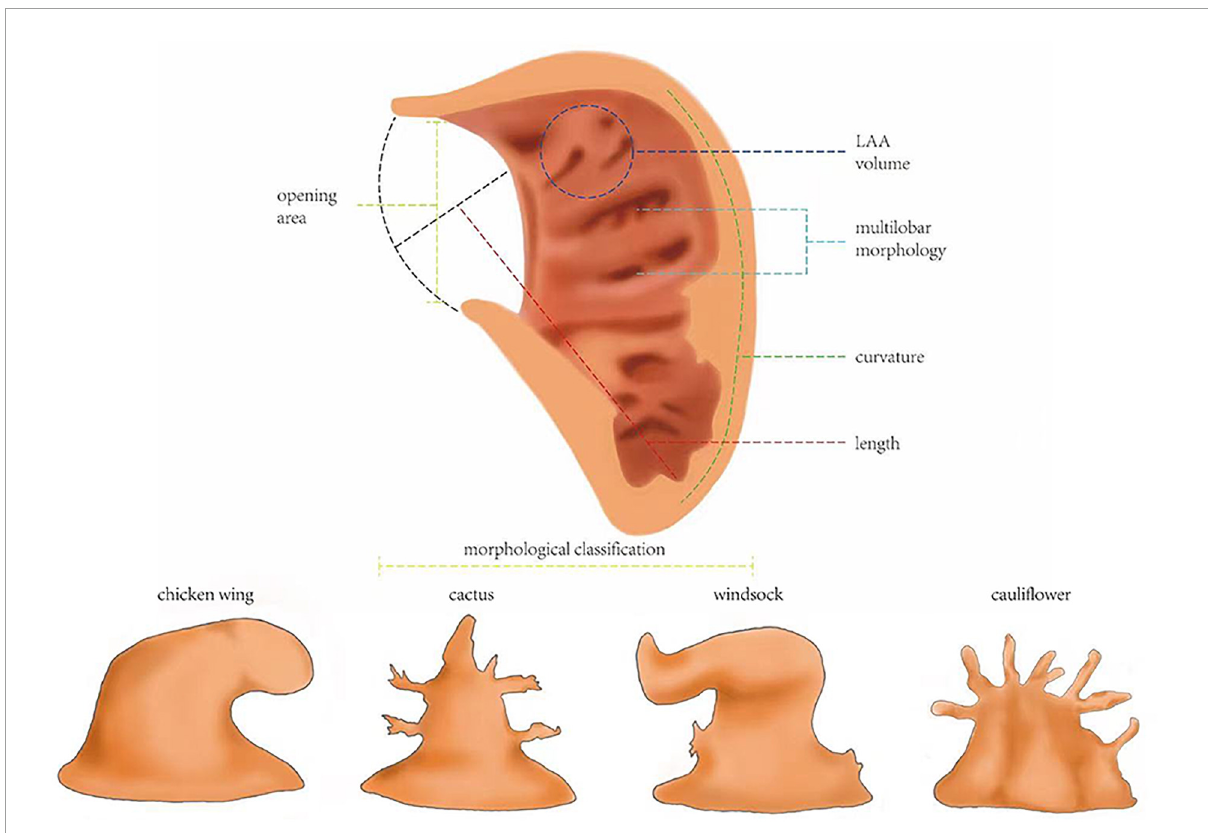
FIGURE2 Definitions of the morphological indicators. Morphological classification: left atrial appendages (LAAs) are divided into four classical types, namely, chicken wing type, cactus type, windsock type, and cauliflower type. Multi-lobar morphology: having several lobules itself is a risk factor for thrombosis. Opening area: the area of the LAA orifice. LAA volume: including LAA end-systolic volume and LAA end-diastolic volume. Length: in the maximum diastolic state of the LAA, the length of the line from the top of the LAA to the midpoint of the junction point of the LAA and left atrial wall to that between the LAA and left upper pulmonary vein. Curvature: the degree to which the curve of LAA deviates from a straight line. Defined as L/D-1, where L is the centerline length and D is the Euclidean distance between the centerline